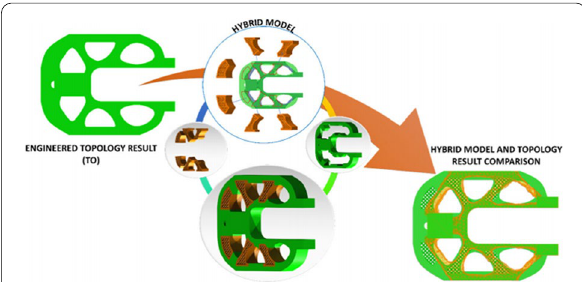
Figure 4 Topology optimization design for additive manufacturing